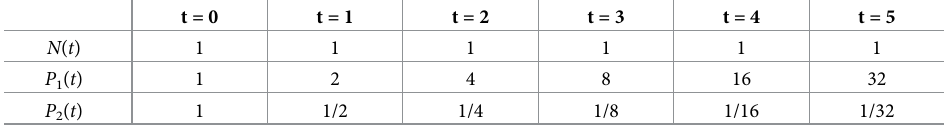
Table 1. Fictional pandemic spread. The variable N ( t ) denotes observed new daily cases, P ( t ) denotes the prediction of new daily cases, and t is the number of